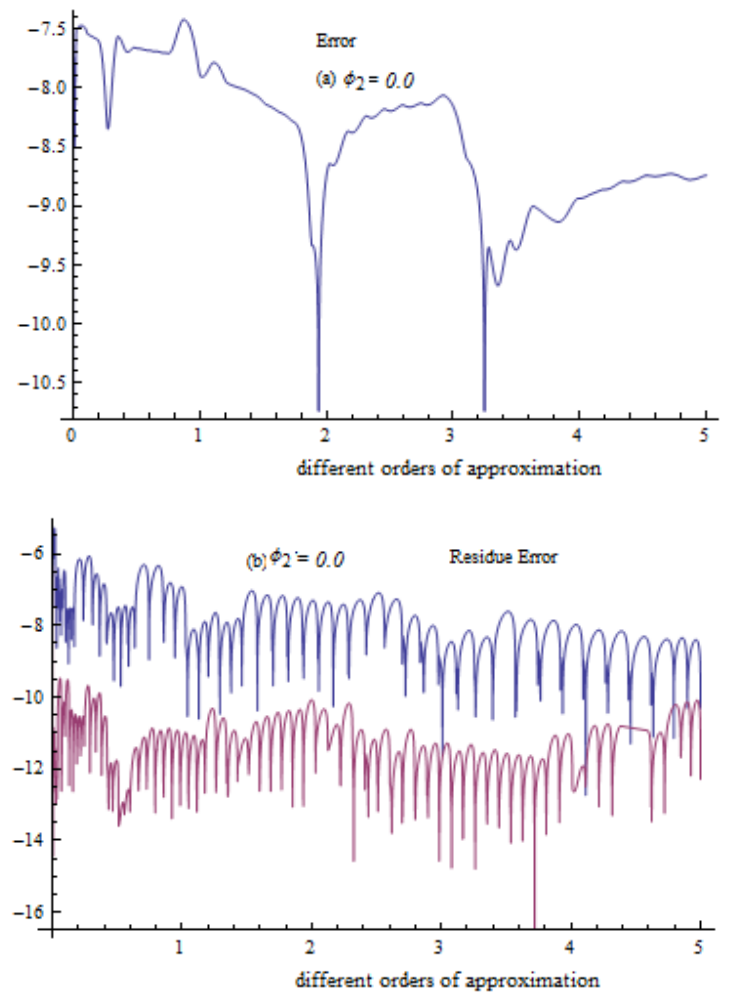
Figure 6. Error ( a ) and residue error ( b ) for 𝜙 2 = 0.0. The blue line represents the average residue error and the red line represent the total average residue error in ( b ).